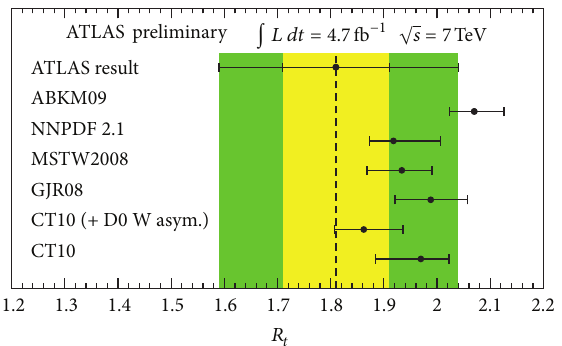
Figure 4: Measured 𝑅 𝑡 value in ATLAS, compared to the values calculated for different NLO PDF sets. The error on the calculated values contains the uncertainty on the renormalisation and factori- sation scales. The combined statistical and systematic uncertainty of the measurement is shown in green, while the statistical uncertainty is represented by the yellow error band. Taken from [31].